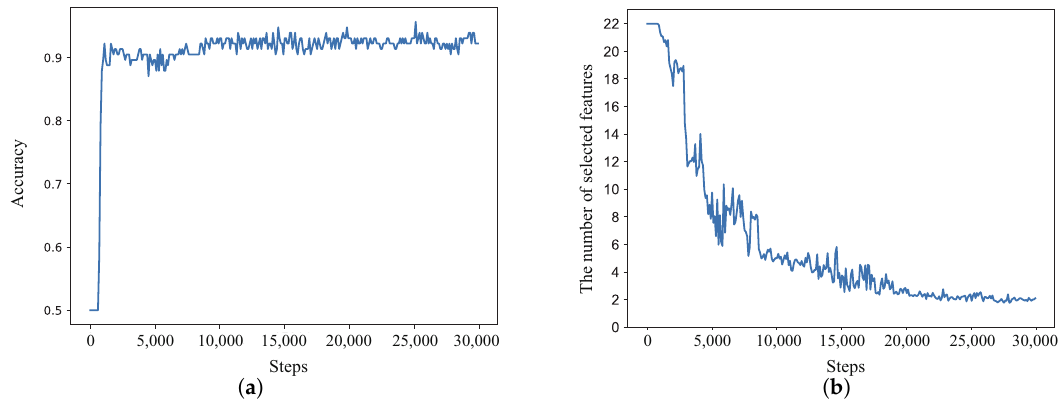
Figure 4. Deep Q-network (DQN) agent classification results as the learning steps during the training session and number of features used for subject 10 were increased. ( a ) Classification results with the deep reinforcement learning agent; ( b ) number of selected features.